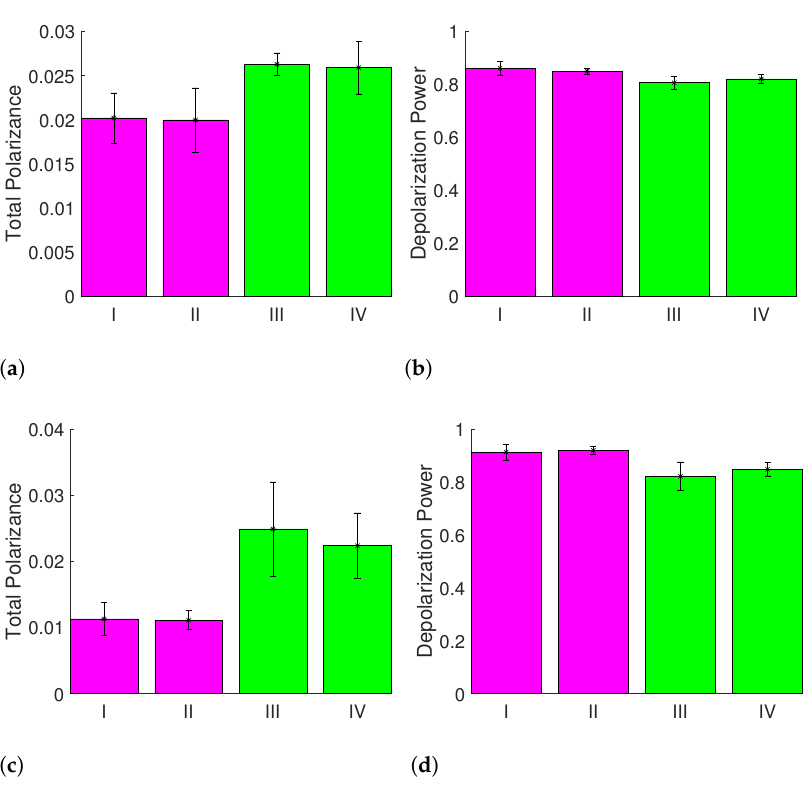
Figure 7. Metrics for the measurements I, II, III and IV for different regions of interest showing clear differences for measurements with and without riboflavin: ( a ) mean value of the total polarizance P using whole images; ( b ) mean value of the depolarization power ∆ using whole images; ( c ) mean value of the total polarizance P using the blue area; and ( d ) depolarization power ∆ using the blue area.